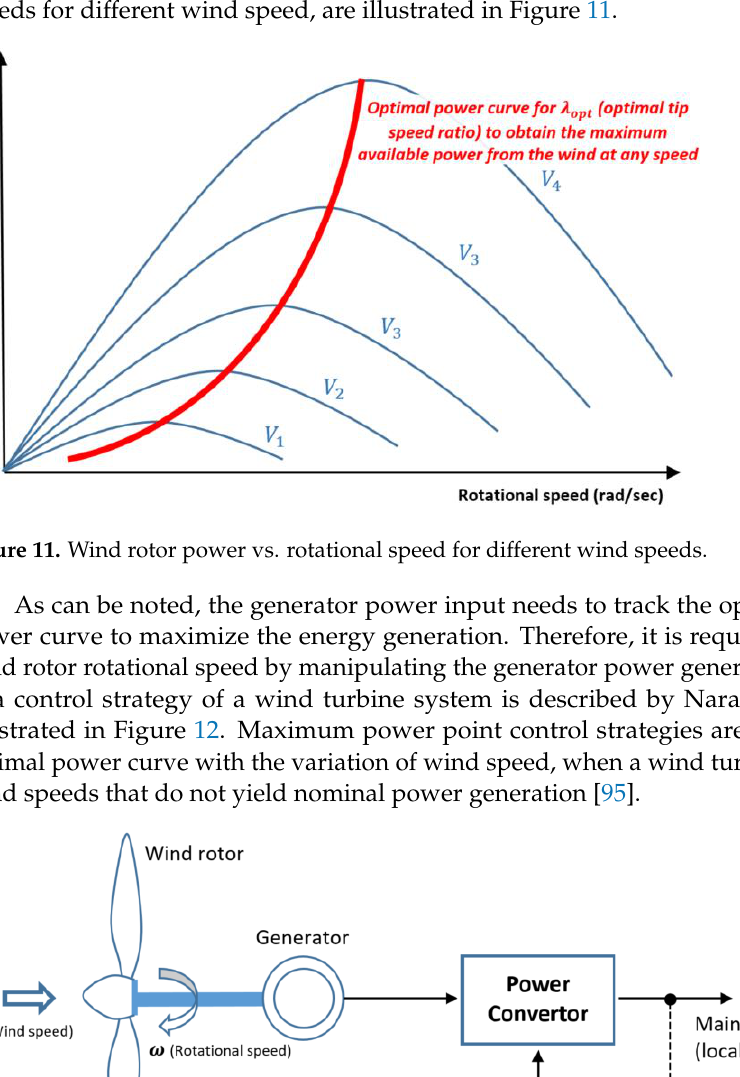
Figure 12. Control strategy of a wind turbine system.